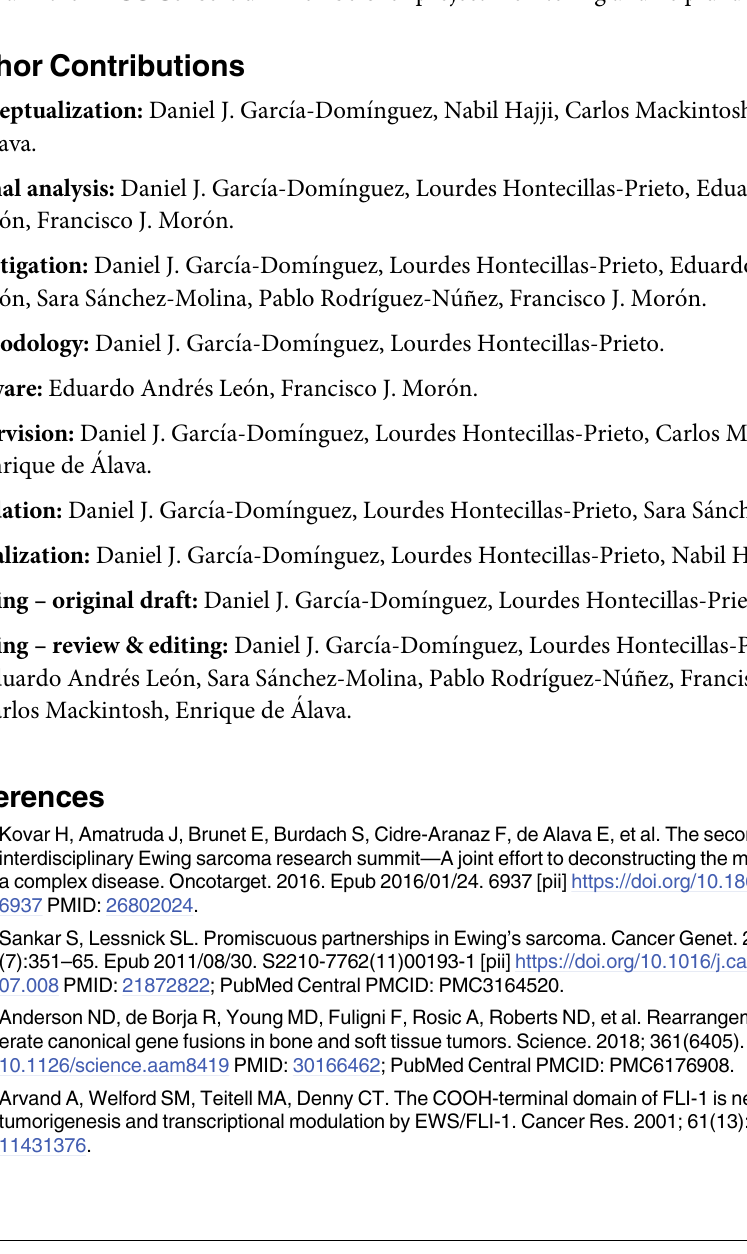
S3 Table. GSEA of rank-ordered genes sets (C2_MSigDB): +dox 24 h HeLa